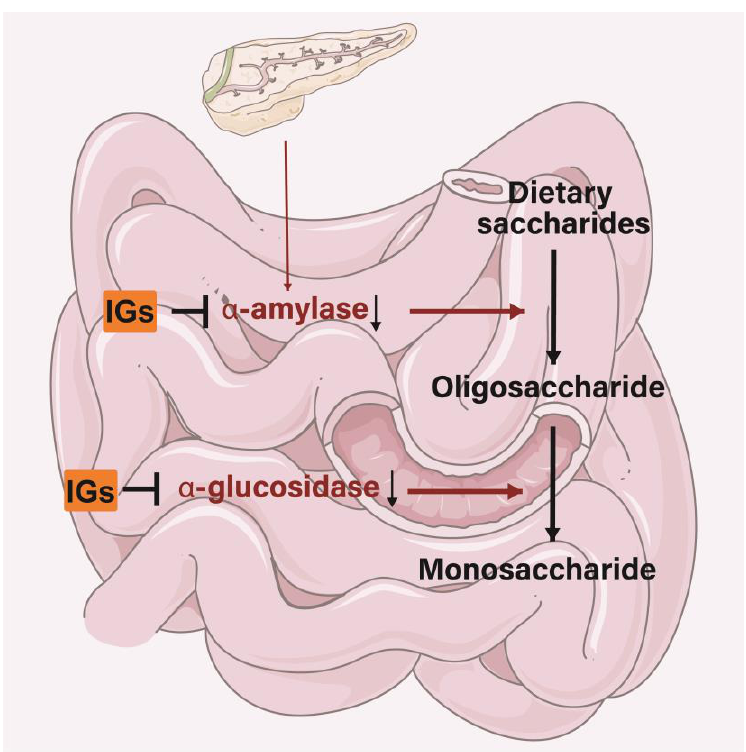
Figure 6. Mechanism of IGs inhibiting α-amylase and α-glucosidase. Moreover, IGs improved the secondary complications of diabetes. In diabetes, the over- expression of aldose reductase induces the conversion of glucose to sorbitol via the polyol pathway, thereby inducing complications of diabetes, such as neuropathy, nephropathy, and retinopathy [189]. Isorhamnetin-7- O - β -neohesperidoside ( 12 ) (IC 50 = 5.45 ± 0.26 µ g/mL) and isorhamnetin 3- O -glucoside ( 4 ) (IC 50 = 21.55 ± 1.52 µ g/mL) exhibited remarkable aldose reductase inhibition activity [12]. It was also found that 4 (25 mg/kg) inhibited rat lens aldose reductase and sorbitol accumulation in streptozotocin-induced diabetic rat tissues [190]. Isorhamnetin 3- O - α - L -rhamnopyranosyl-(1 → 6)- β - D -glucopyranoside ( 24 ) (IC 50 = 9 µ M) was determined to exhibit a high degree of rat lens aldose reductase inhibitory activity in vitro